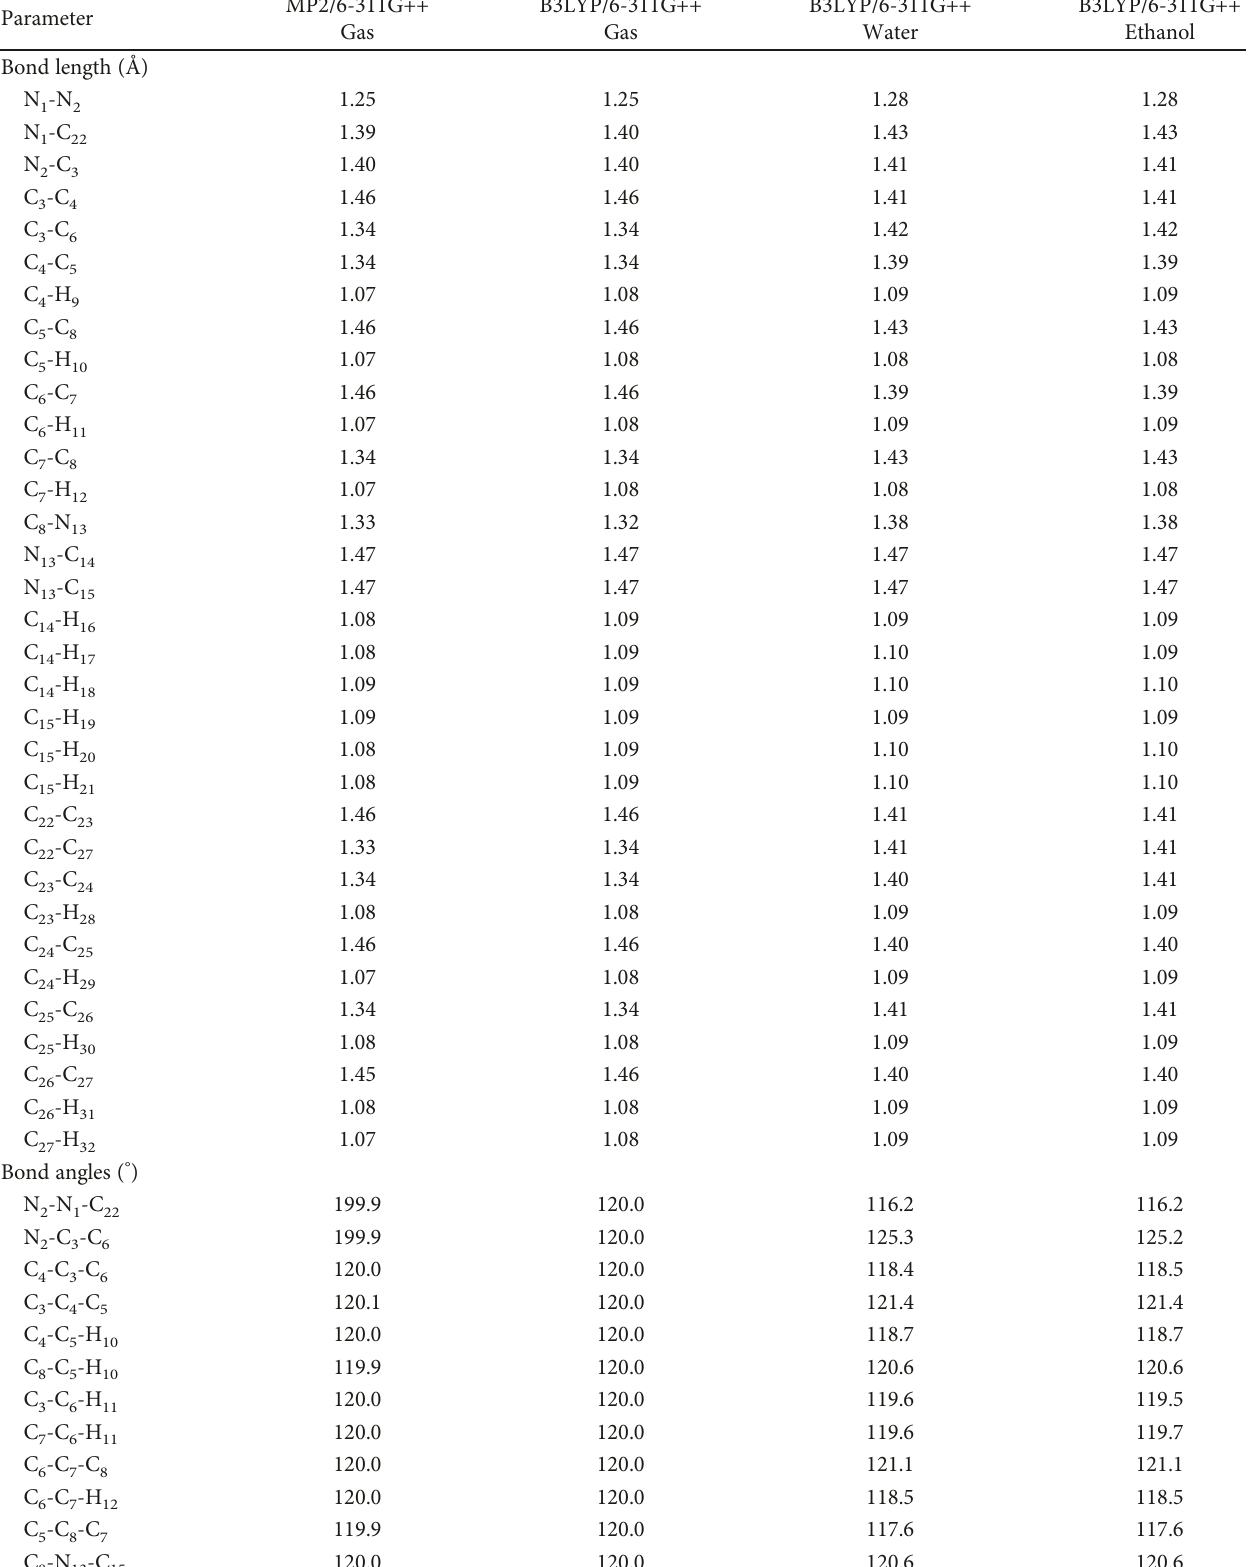
Table 1: Optimized geometric parameters (bond lengths, bond angles, and selected dihedral angels) of DMAB at the DFT/B3LYP/6- 311G++ level and at